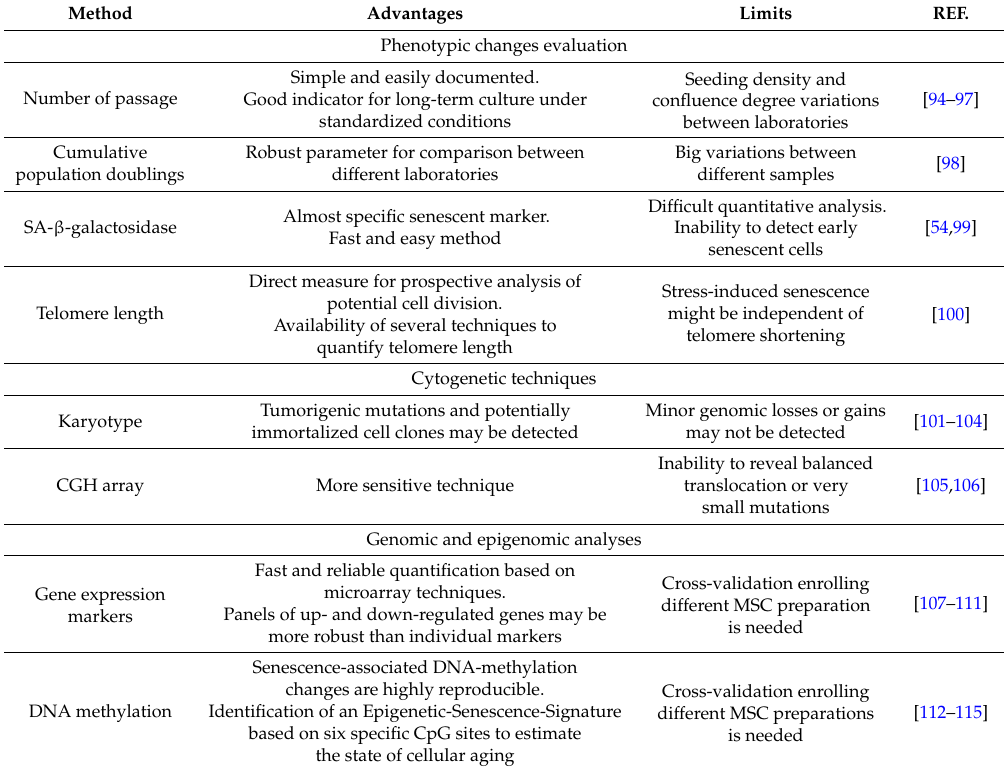
Table 1. Methods to monitor changes in senescent